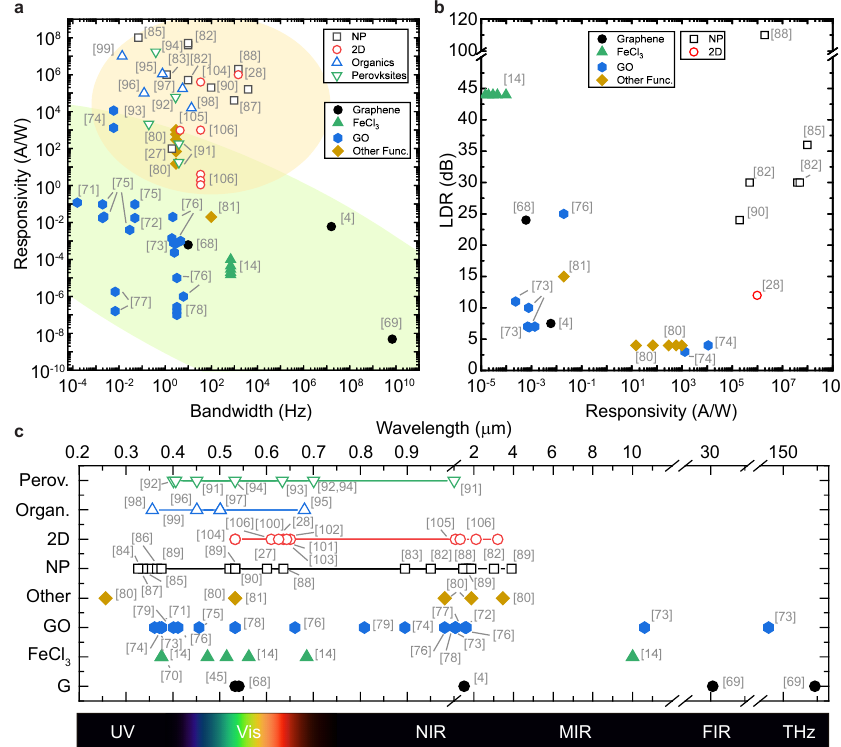
Figure 2. Graphene-based photodetectors performance comparison. ( a ) responsivity vs. bandwidth and ( b ) LDR vs. responsivity in functionalised (filled symbols) and hybrid (open symbols) graphene PDs. Shaded areas encircle the majority of points belonging to each group; ( c ) operational wavelength range for different graphene-based PDs, points correspond to experimentally tested wavelengths, lines represent full spectral scans. Detailed data in Table 2, reference numbers in brackets. NP = nanoparticles, 2D =